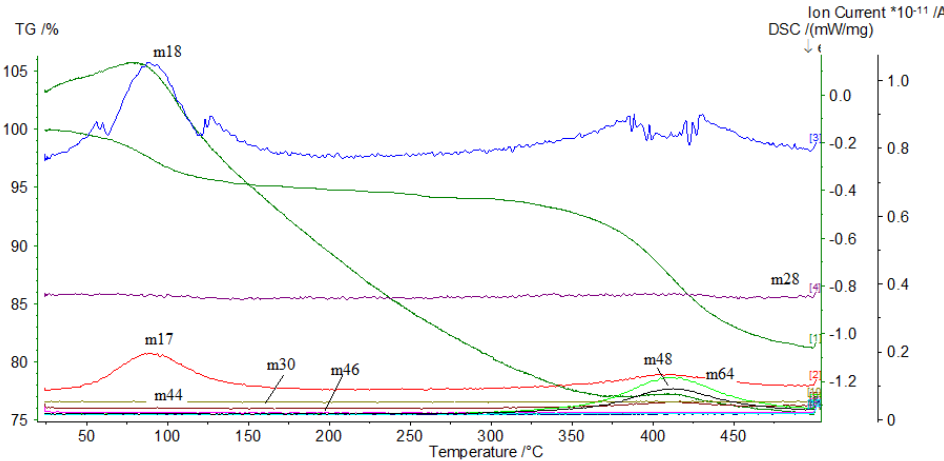
◦ C in Ar atmosphere, rate 5 ◦ C/min.